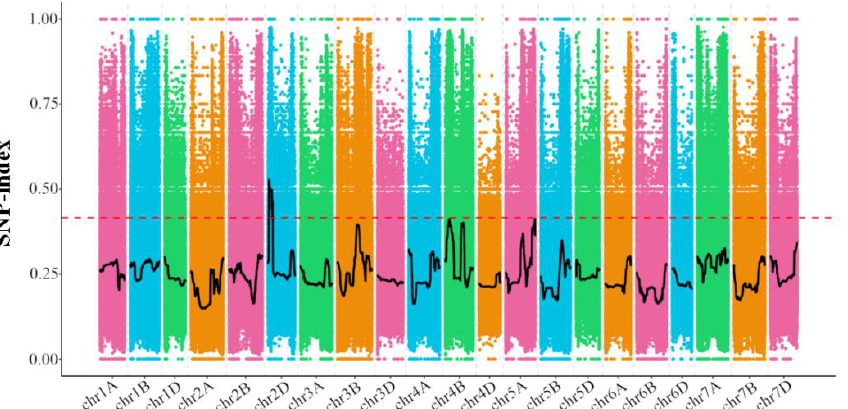
Figure 2. Distribution of SNP-index values on wheat chromosomes using MutMap. SNP-index = 0 means bulked DNA representing wild-type genome. Color dots represent SNP-index by calculation, black line is SNP-index plot. Regression lines were obtained by averaging SNP indices from a moving window of the 4 Mb interval with 10 kb increments. Red line refers to theoretical correlation-threshold line.